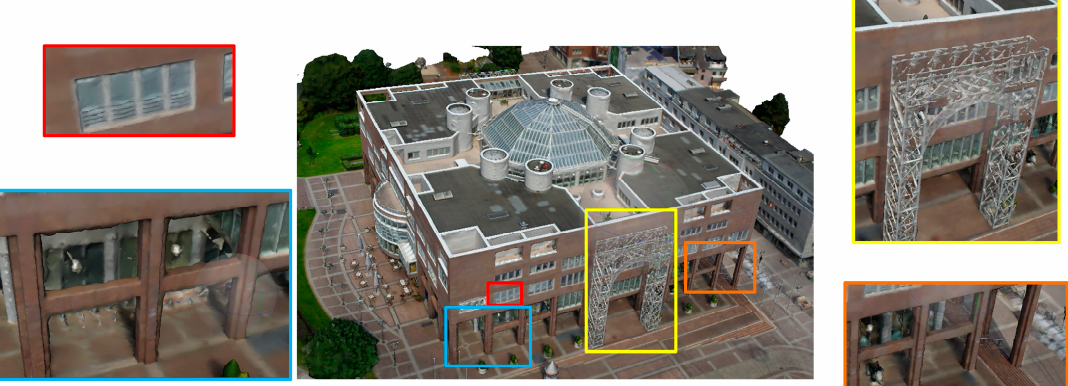
Figure 18. The model generated after the aerial–terrestrial images were aligned by the proposed method.